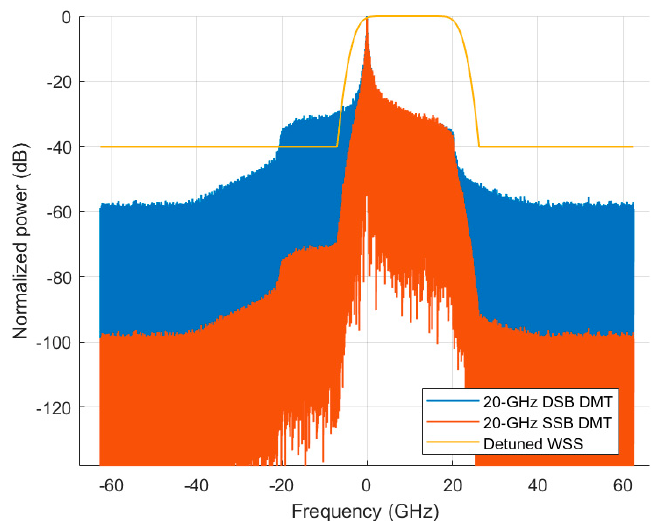
Figure 3. DMT SSB optical spectrum (red), obtained by a 9.5-GHz detuned WSS (orange) filtering of a DMT DSB signal with 20-GHz electrical bandwidth and 40-GHz optical bandwidth (blue).